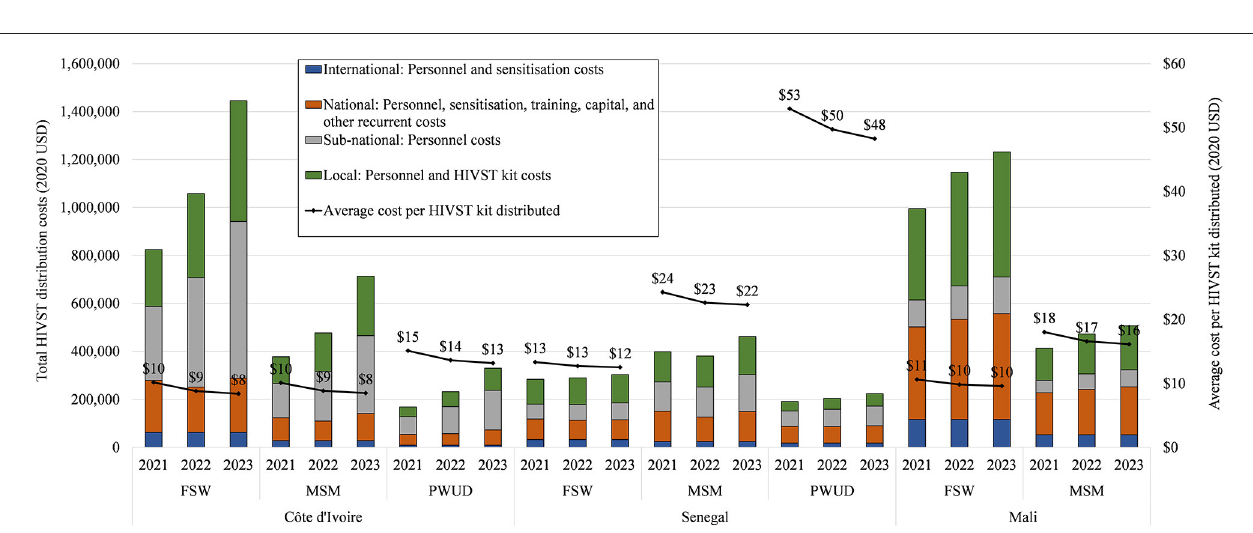
FIGURE 3 | Total and average intervention costs in transition (2021) and at scale-up (2022–2023) by country and key population.